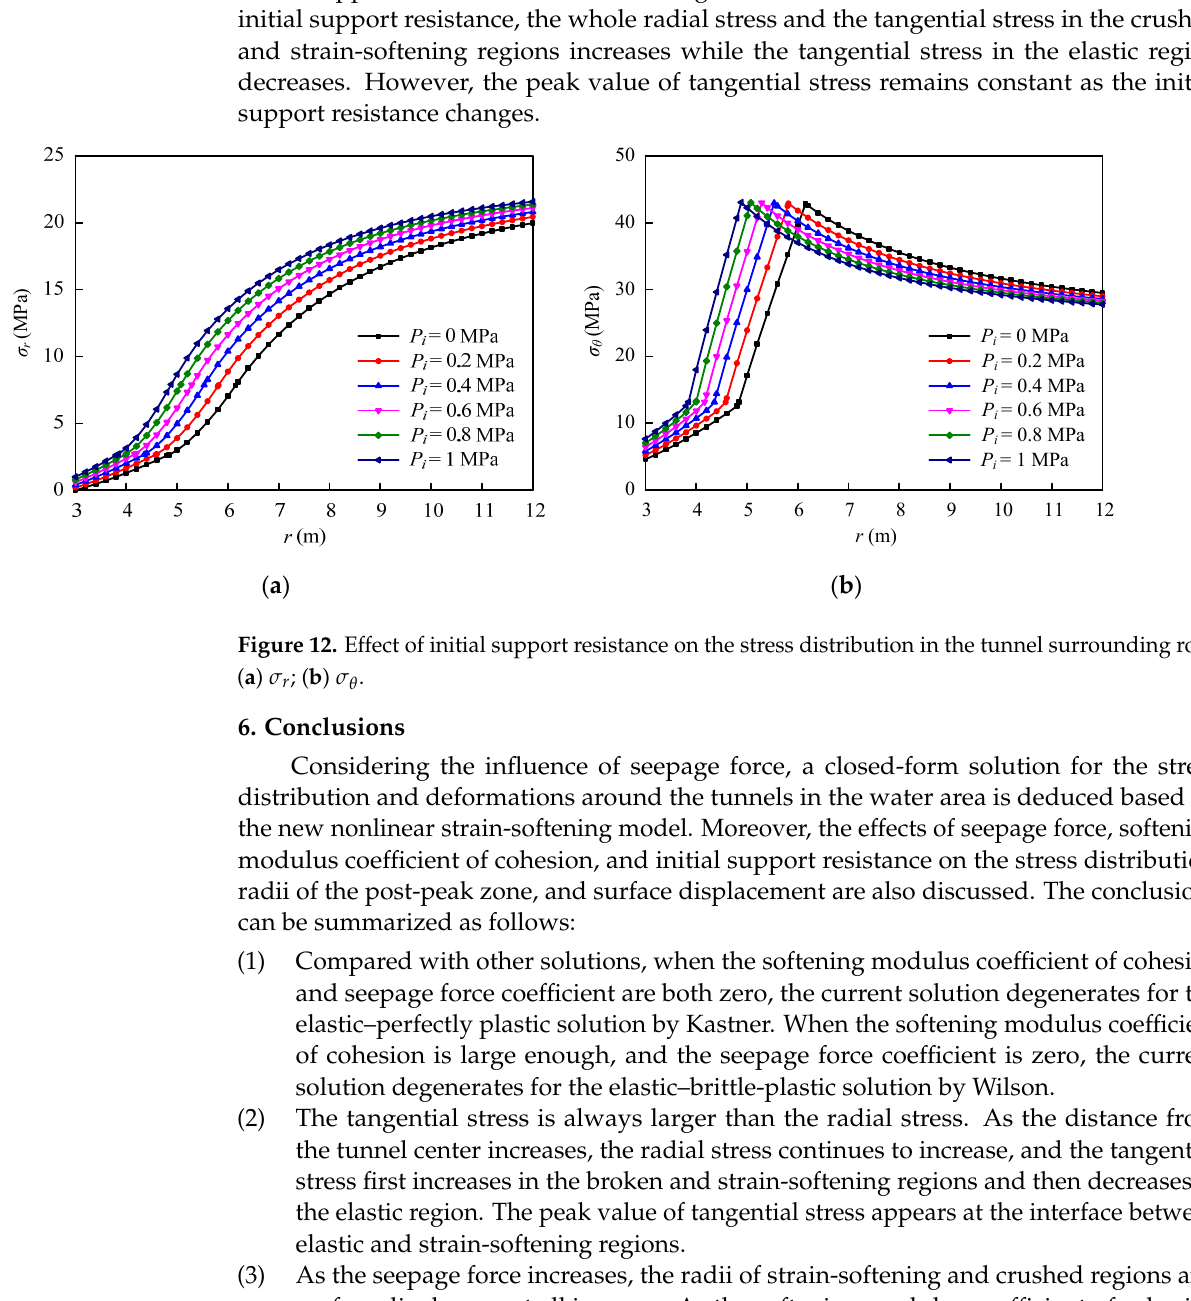
Figure 11. Effect of initial support resistance on the radii of strain-softening and crushed regions and surface displacement. ( a ) R s and R c ; ( b ) u 0 .